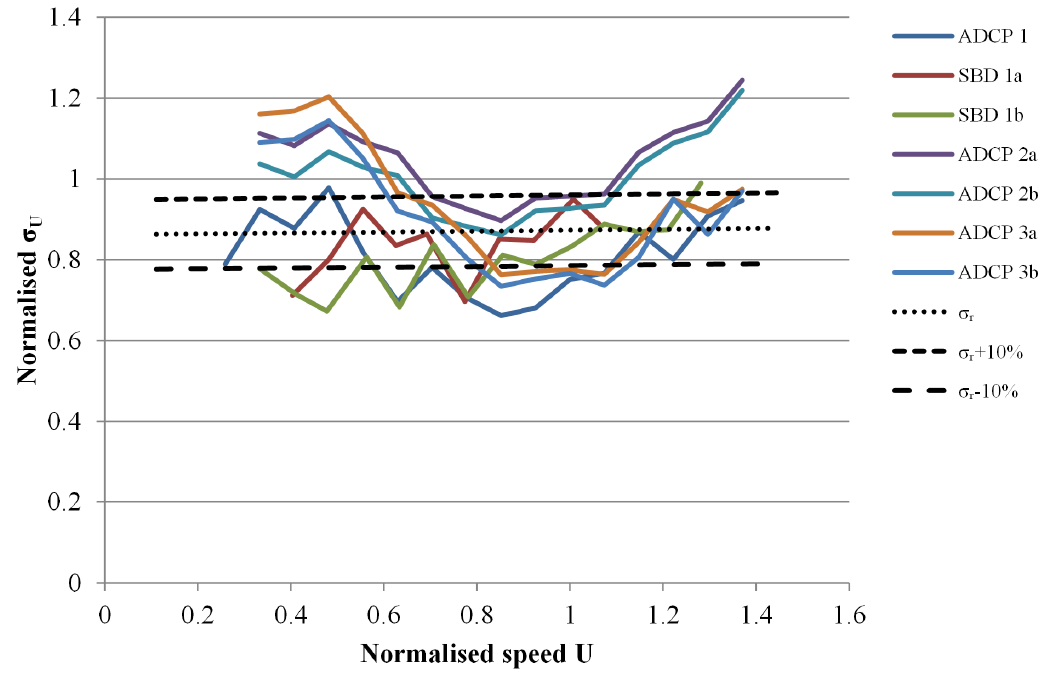
Figure 2. Ebb direction σ U measurements.